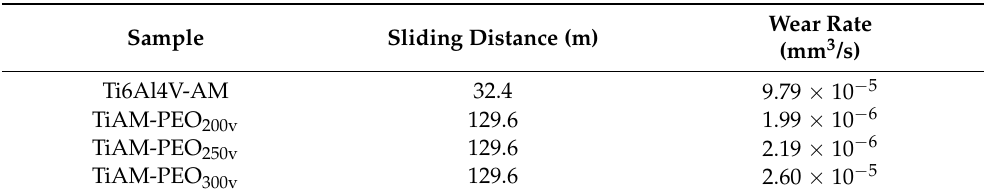
Table 2. Breakage time and wear rate assessed after the abrasive wear test in ball-on-plate configura- tion for PEO